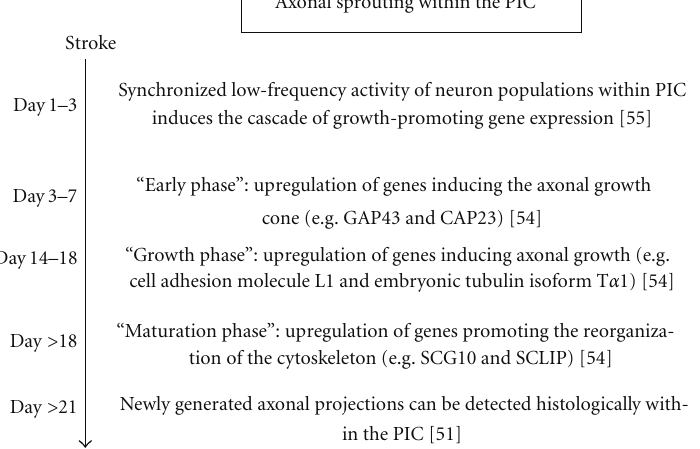
Figure 2: Timescale illustrating the milestones of axonal sprouting within the PIC after a photothrombotic cortical stroke in rats.